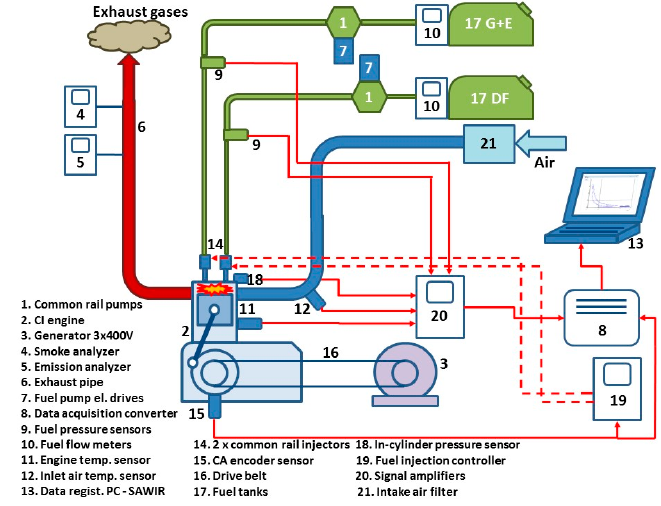
Figure 3. Test bed scheme. Table 5. Engine main specifications.